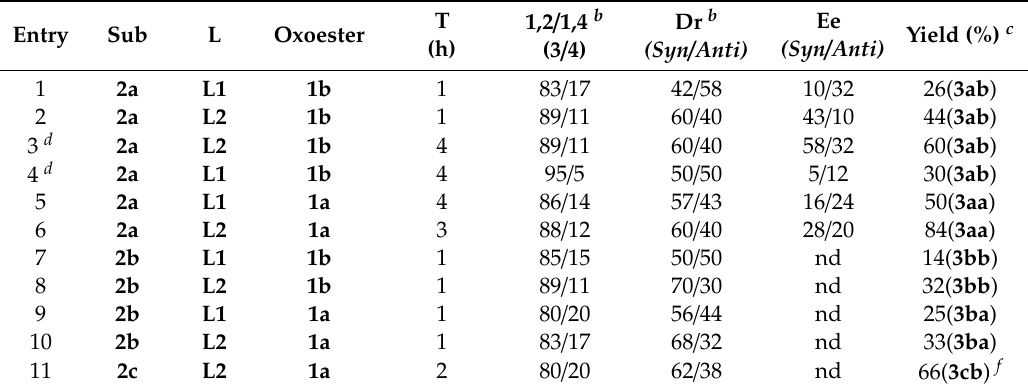
Table 1. Results of N-acyl Mannich reaction of oxoesters 1a,b with N,O -acetals 2a – c. a.